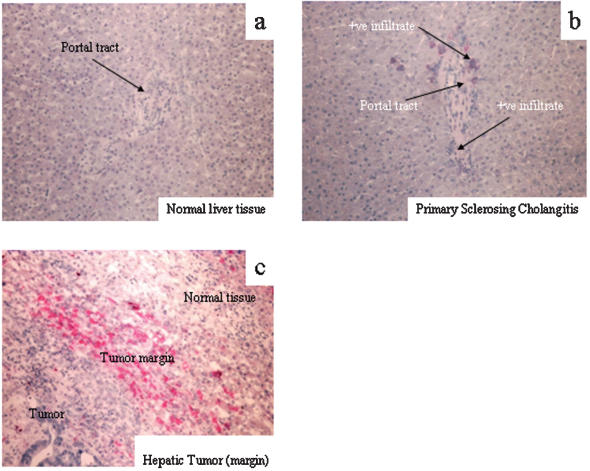
Immunolocalisation of C4BP in human liver tissue. This figure shows three representative sections of liver tissue stained for C4BP. Panel a shows normal liver tissue which is predominantly negative. Panel b shows PSC liver tissue showing the presence of strongly staining inflammatory cells surrounding the portal tract and within the sinusoids. Panel c shows hepatic tumour tissue taken from a hepatic resection for secondary liver cancer (colorectal hepatic metastasis) where very strong staining was observed in the tumour tissue and the inflammatory infiltrate at the tumour margin.